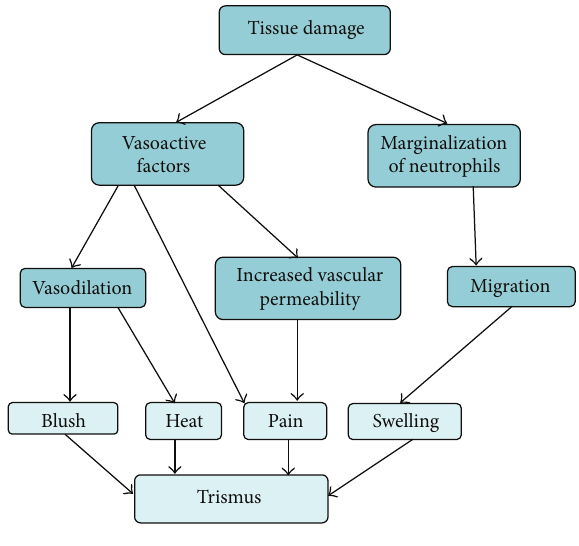
Figure 1: Inflammatory